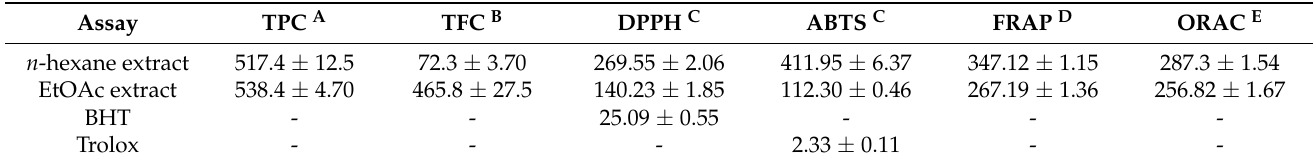
Table 2. Total phenolic and antioxidant activity of G. pinifolium.